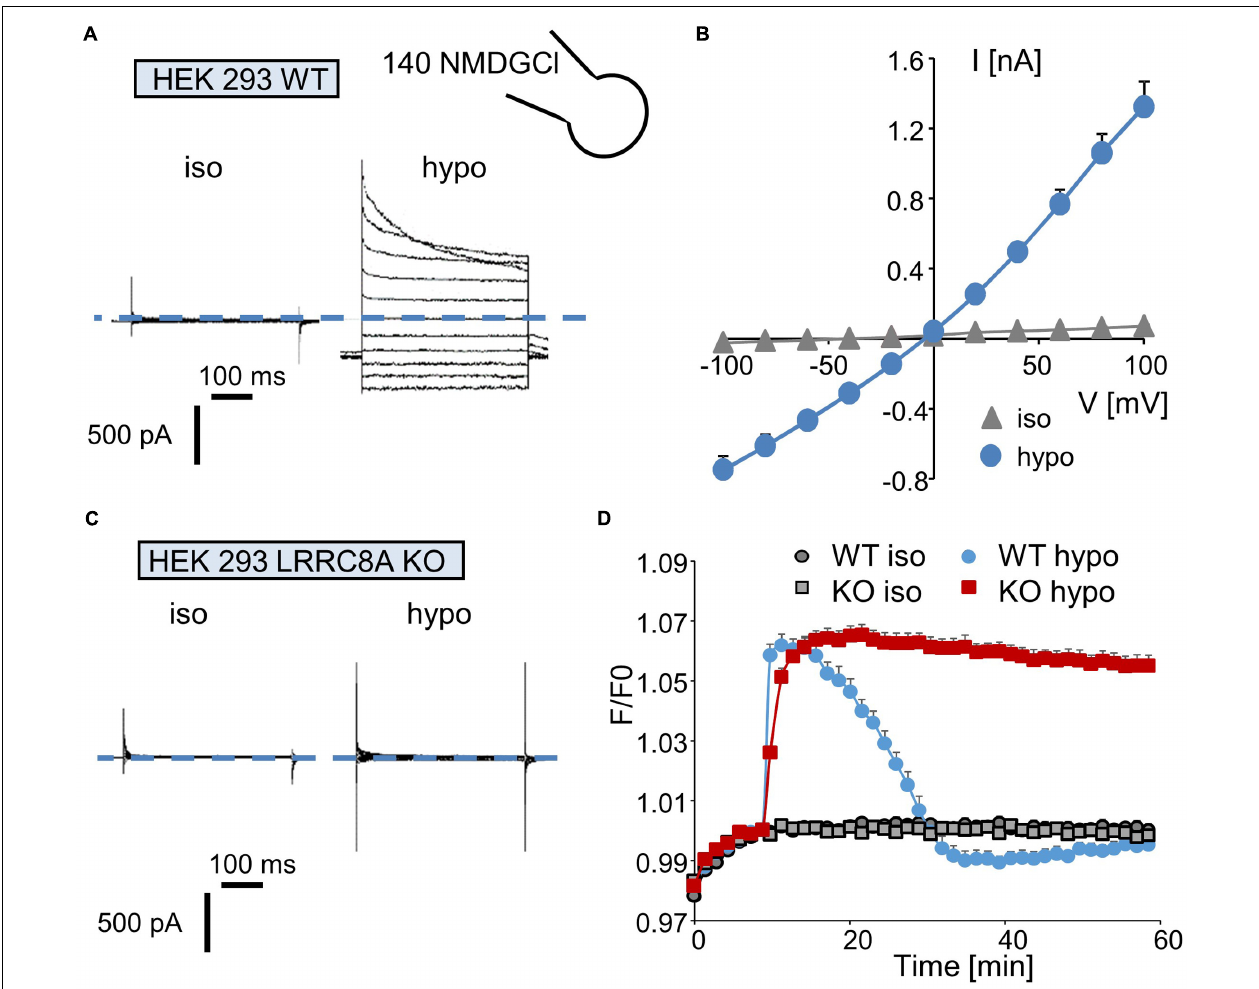
FIGURE 2 | Quantification of I Cl , swell and of the regulatory volume decrease (RVD) process in wild-type and LRRC8A KO HEK-293 cells. (A,C) Whole-cell currents recorded in WT (A) and LRRC8A KO (C) HEK-293 cells maintained under control conditions (in an iso-osmotic bath solution) or exposed to hypotonic medium for 5 min. The membrane potential was held at –50 mV, and currents were elicited by a train of 11 voltage steps (400 ms duration) between –100 and +100 mV in +20-mV increments. (B) Mean current/voltage relationships measured in HEK-293 WT recorded under iso-osmotic conditions (iso) and 5 min after exposure to hypotonic medium (hypo). Current values were measured 10 ms after the onset pulse. The reported values are the mean ( ± SEM) values obtained from 35 individual cells. (D) Quantification of RVD measured in WT and LRRC8A KO HEK-293 cells following a hypotonic challenge. The measurements were performed using calcein relative fluorescence quenching induced by changes in cellular volume. After a 10-min period for fluorescence stabilization, the bath solution was replaced by an iso-osmotic solution (300 mOsm.l − 1 ) or by a hypo-osmotic solution (100 mOsm.l − 1 ). Fluorescence emitted at 520 nm was measured every 90 s over a 60-min